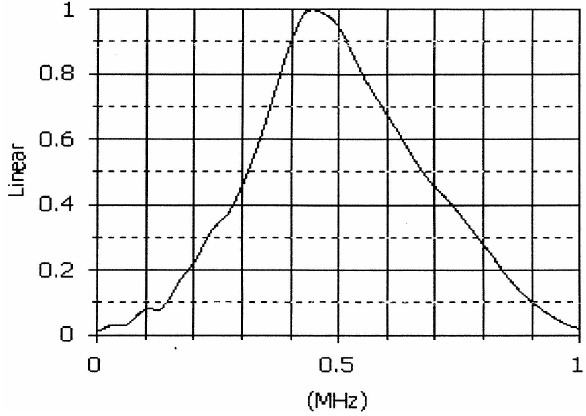
Figure 8. Frequency spectrum of the ultrasonic transducer. Table 1. Ultrasonic transducer amplitude test for the frequency selection.